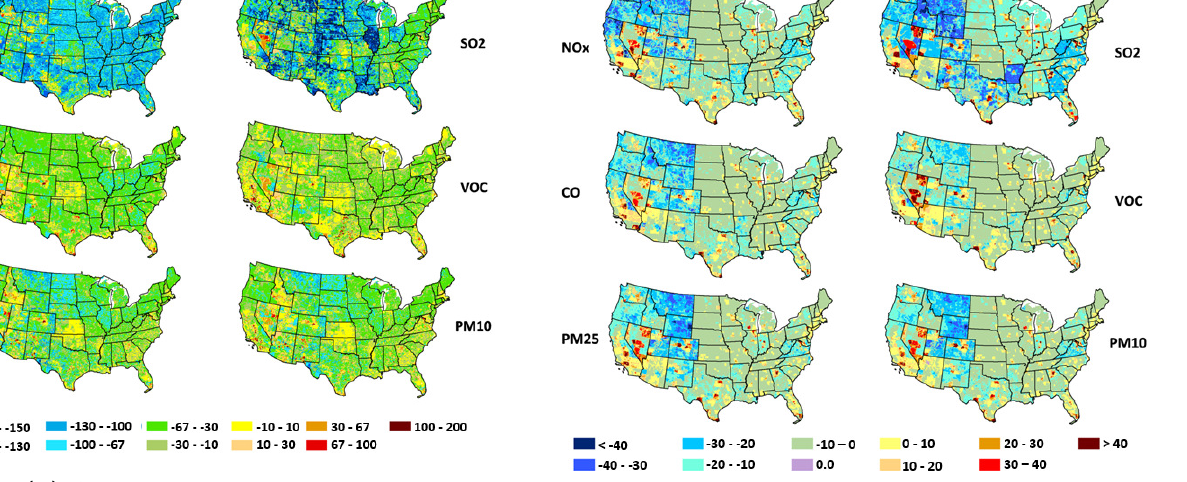
Figure 9. FD (%) of annual 2050 emissions, Future minus Futur- eRegGF , for grid cells in the CONUS 12km domain. ( Future : 2050 inventory, 2050 surrogates, county growth factors; FutureRegGF : 2050 inventory, 2050 surrogates, regional growth